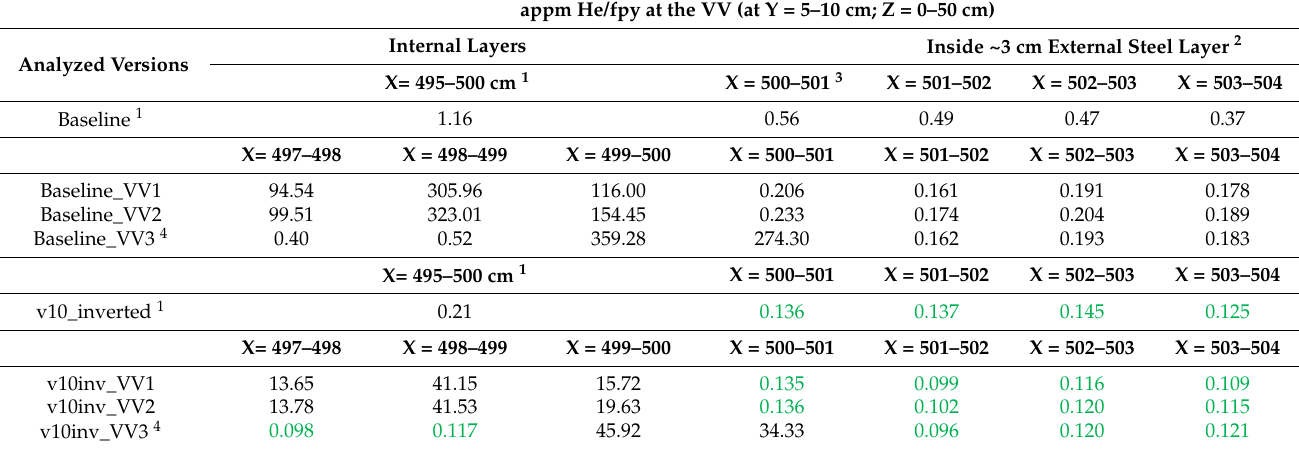
Table 11. Helium production in the VV for the baseline and v10_inverted versions with modified